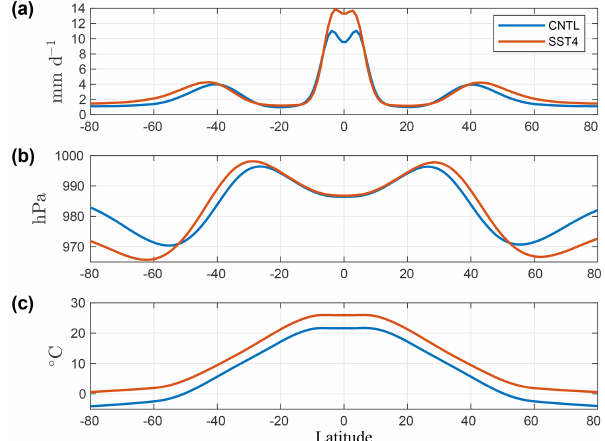
Figure 2. Zonal mean (a) total precipitation (mmd − 1 ), (b) mean sea level pressure (hPa), and (c) 950hPa temperature ( ◦ C) averaged over 10 years of simulation. Blue line shows CNTL and red